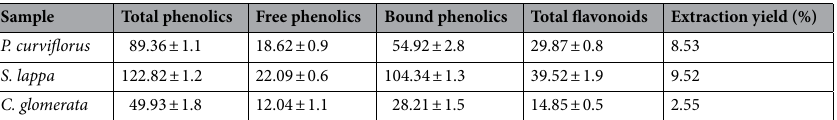
Table 1. Total, free, bound phenolics content (mg GAE/g), flavonoid (mg RE/g) and extraction yield of methanol extract of P. curviflorus , S. lappa and C. glomerata. Each value in the table is expressed as mean ± S.D (n = 3).